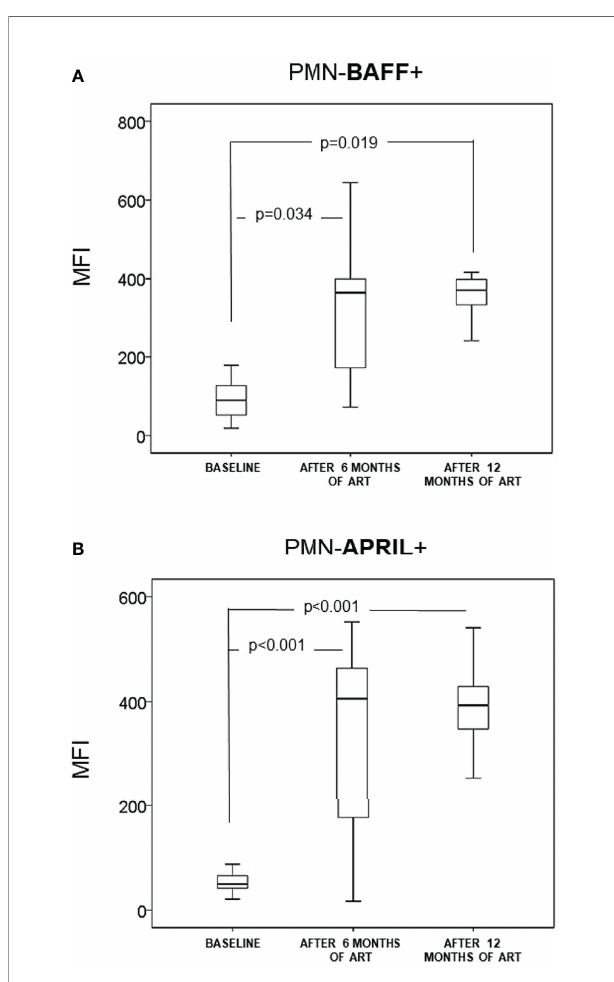
FIGURE 2 | Neutrophils (CD14-CD15+CD16+) (PMN) expression of B cell- modulating markers: intracellular BAFF (A) and intracellular APRIL (B) in naïve infected patients (n = 35). They were analyzed at baseline and after 6 and 12 months of antiretroviral treatment. Data are provided as median, interquartile range (boxes) and range of the mean fl uorescence intensity (MFI), at baseline and after 6 and 12 months of antiretroviral